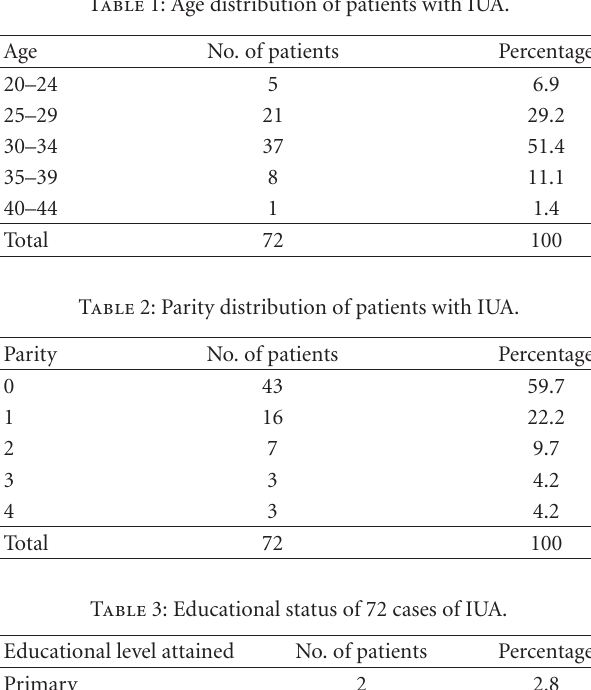
Table 1: Age distribution of patients with IUA.